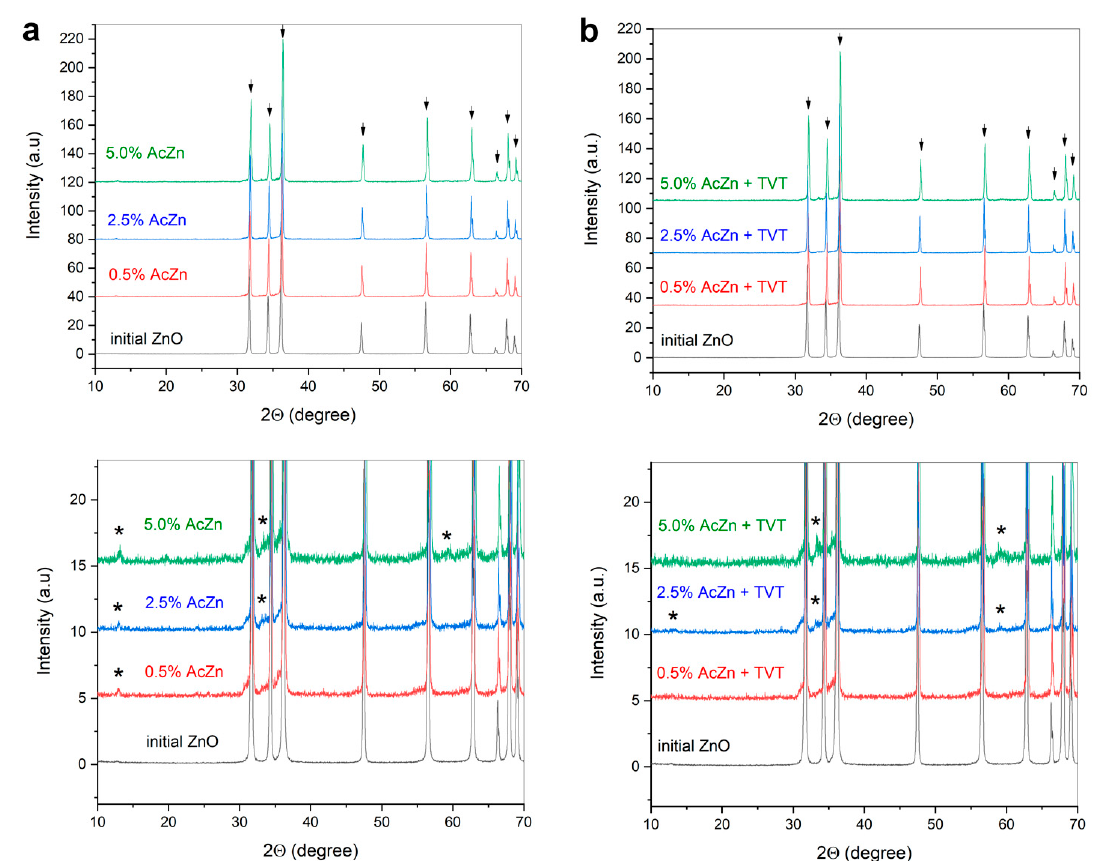
Figure 2. XRD patterns of initial ZnO powder, ZnO powders impregnated by 0.5–5.0 wt.% ZnAc ( a ), ZnO powders after impregnation by 0.5–5.0 wt.% ZnAc followed by TVT ( b ). Arrows indicate ZnO (COD #9008877), asterisk indicated traces of the LBZA (probably).